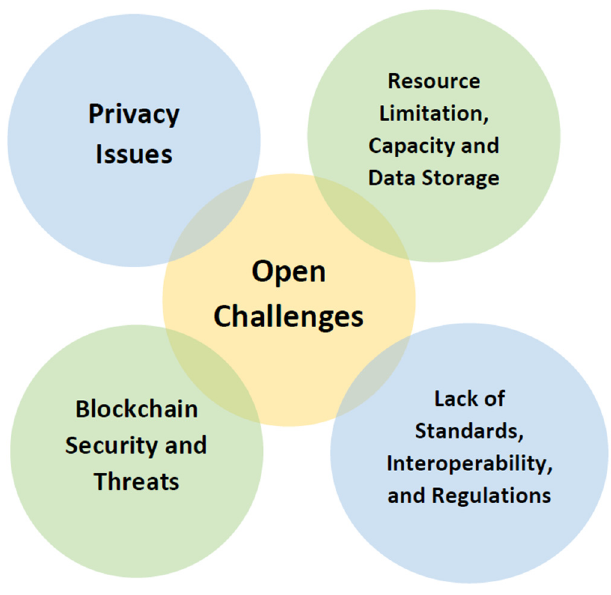
Figure 17 . Open challenges in using AI-powered Blockchain for public health. Figure 17. Open challenges in using AI-powered Blockchain for public